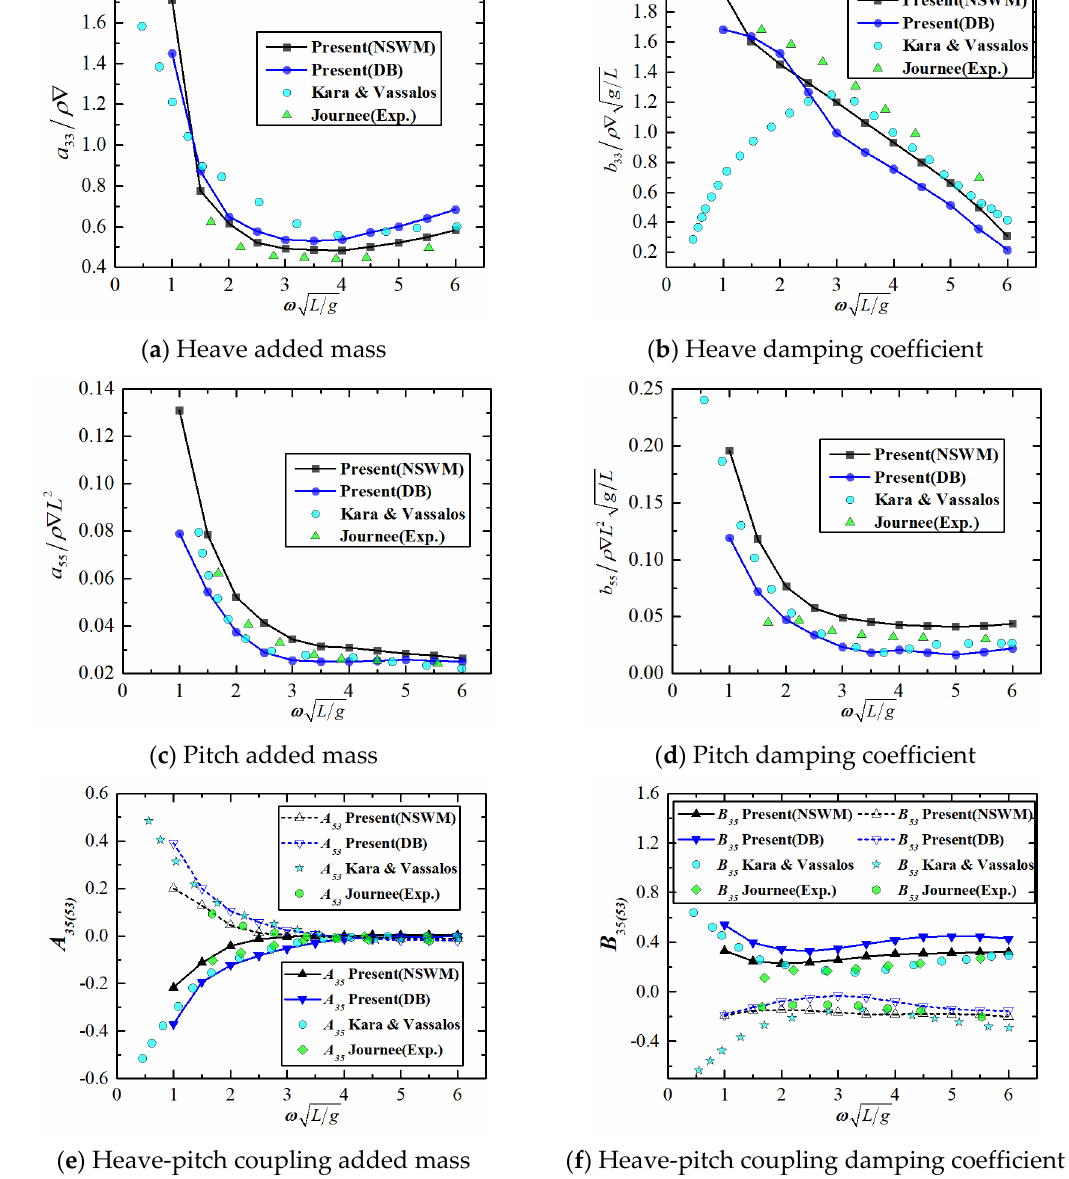
Figure 8. Added masses and damping coe ffi cients of Wigley I ship ( Fr = 0.4).